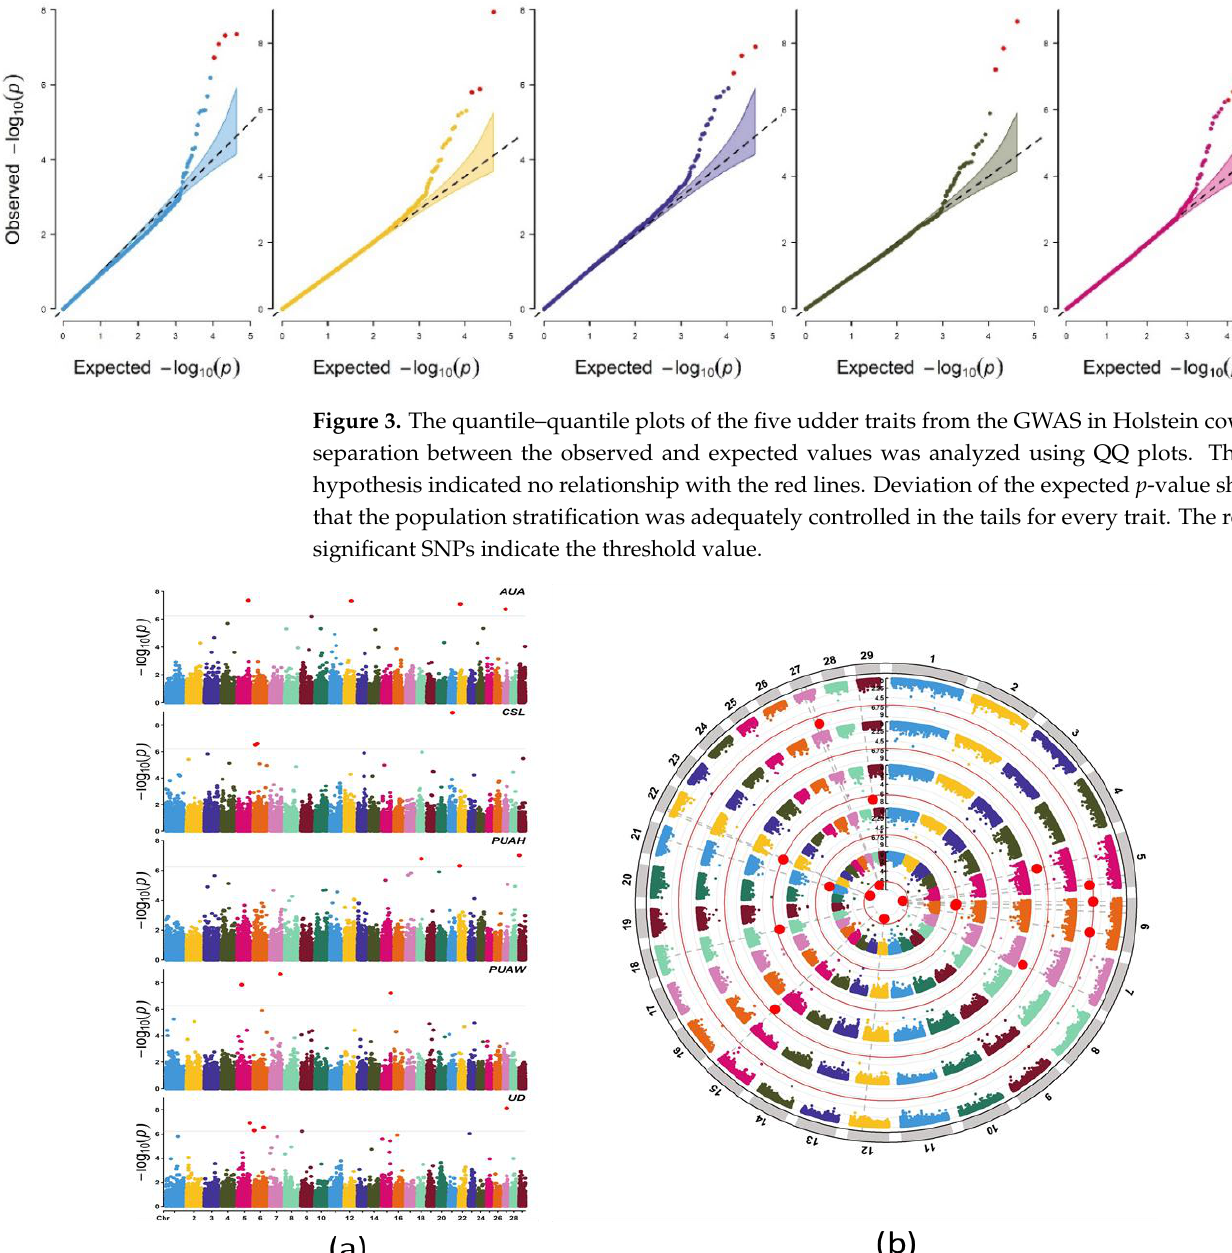
Figure 4. ( a ) Manhattan plots established from the GWAS results of the udder conformation traits in Holstein cattle. The significant threshold was p < 5.9 × 10 − 7 . The Manhattan plot displays genomic SNPs on the horizontal axis (x-axis) along with chromosomes and the negative logarithm of each SNP’ association p value on the vertical axis (y-axis). After the Bonferroni correction, the green line shows a significant threshold level. ( b ) In the Circular Manhattan plot, the udder conformation traits were plotted from outside to inside,